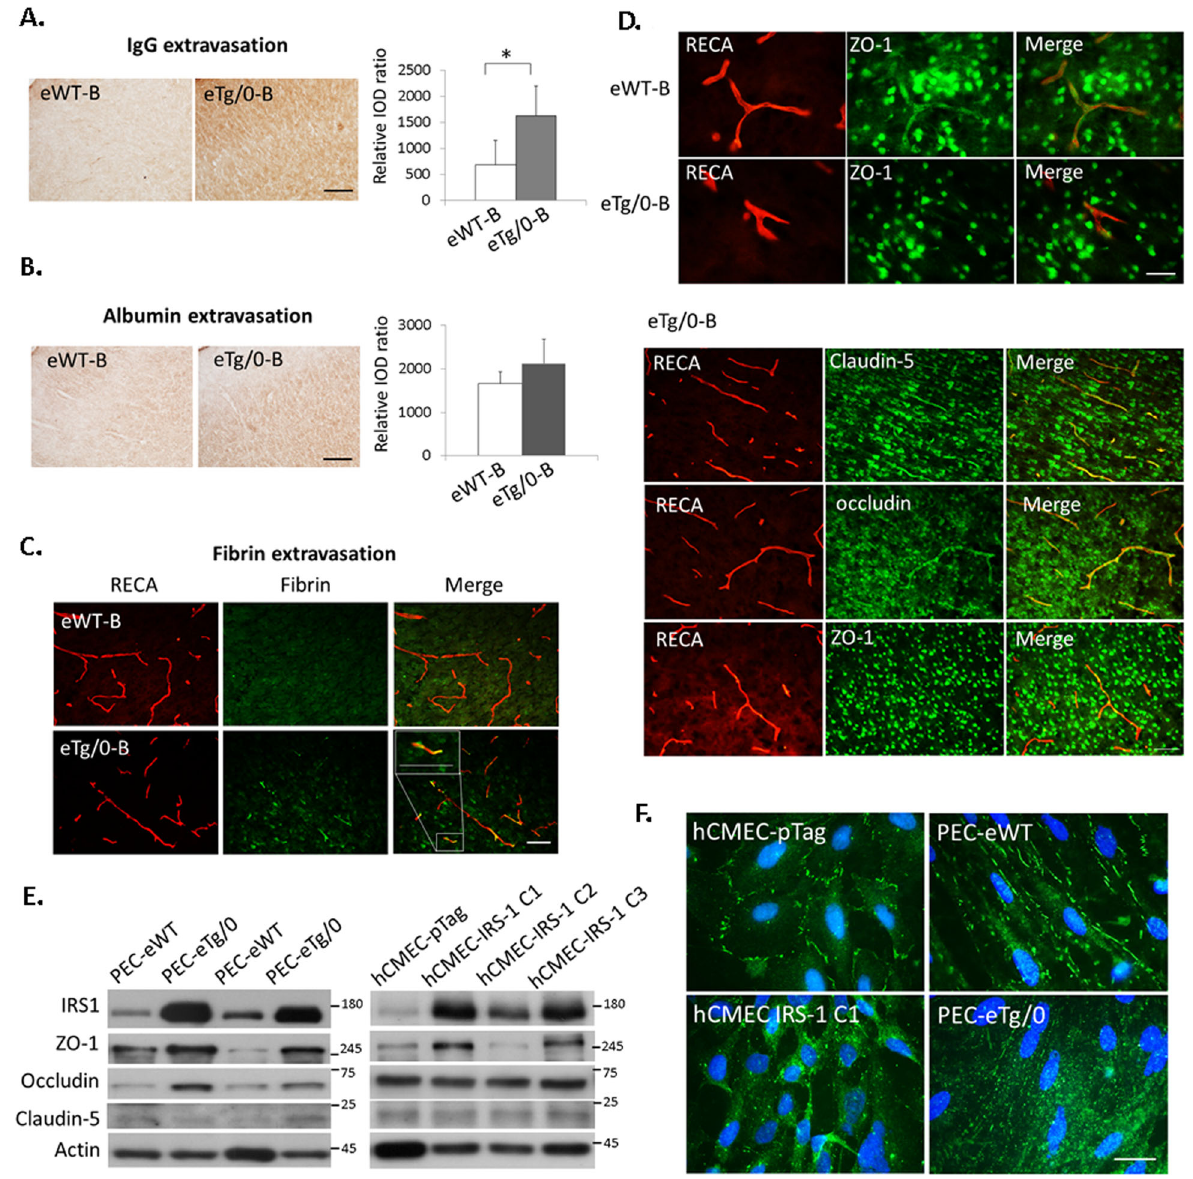
Fig. 4 Disturbed BBB functions and aberrant distribution of tight junction protein ZO-1 by IRS-1 overexpression in the endothelial cells. A , B Representative images illustrate IgG and albumin extravasation in the cerebral cortex of endothelial-speci fi c IRS-1 transgenic rats (eTg/0) and wide type control rats (eWT) at basal state ( B , i.e. on P7 before HI), and the relative integrated optic density (IOD) of IgG ( N = 6, P = 0.01, t = − 3.16) and albumin ( N = 6, P = 0.077, t = − 2.117) signals was quanti fi ed. Scale bar: 125um. Independent t -test was used for statistical analysis. All data are presented as mean ± SD. * P < 0.05. C The eTg/0 rats had more perivascular fi brin deposits than that of eWT rats at basal state. N = 4, Scale bar: 50um. Inset scale bar: 50 μ m ( D ) (Upper panel), The eTg/0 rats had less tight junction protein ZO-1 expression that co- localized with RECA( + ) vessels than that of eWT rats at basal state. N = 4, Scale bar: 25 μ m. (Lower panel) In the eTg/0 rats at basal state (eTg/0- B), in contrast to ZO-1, other tight junction proteins (claudin-5 and occludin) showed more co-localized with RECA ( + ) vessels. Scale bar: 50 μ m. E Upregulation of IRS-1 associated with high level of ZO-1 protein expression in the primary endothelial cells (PEC) from eTg/0 pups (PEC-eTg/0) and IRS-1 overexpressed hCMEC clones (hCMEC-IRS-1 C1) compared to PEC from eWT pups (PEC-eWT) and hCMEC control clones (hCMEC-pTag), respectively. N = 5. F The distribution of ZO-1 became scattered throughout the cytoplasm of hCMEC-IRS-1 cells and PEC-eTg/0 compared to that of hCMEC-pTag control cells and PEC-eWT. N = 4, Scale bar: 25 μ m. insulin receptor is enriched in the developing brain compared IRS-1 overexpression resulted in disrupted tight junction protein with the adult brain, and also enriched in the neurons and assembly, resulted in increased neurovascular damage and endothelial cells [20, 21]. In addition to regulating glucose worsened brain damage outcome. Thus, IRS-1 overexpression in metabolism, insulin signaling pathway has pleiotropic effects on the neuron and the endothelial cells play opposite roles in the the central nervous system [22]. Under stress conditions, insulin neurovascular integrity after HI. signaling restores oxidative stress-induced Akt inactivation, Insulin signaling in the brain has become an important issue increases gene transcription of Bcl-2, precludes caspase-3 expres- because brain insulin resistance appears to be an early and sion, suppresses glutathione peroxidase-1 expression [23 – 25]. common feature of many neurodegenerative diseases [19]. The Cell Death Discovery (2021)